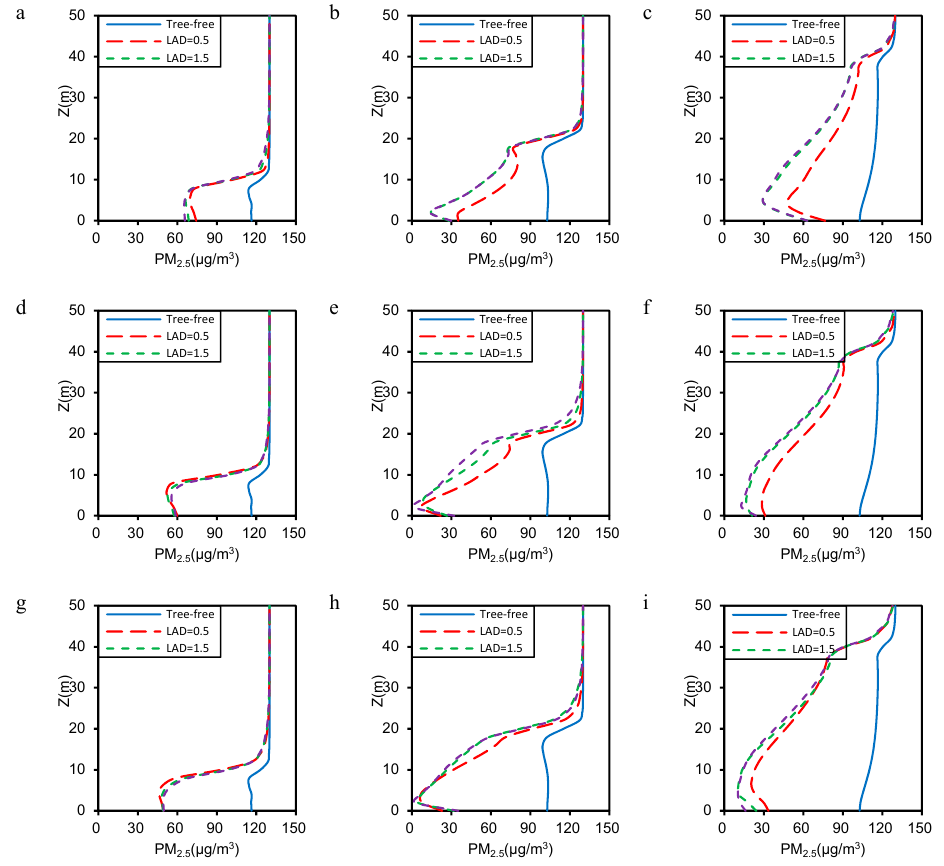
Figure 12. PM 2.5 for H/W = 0.5 ( left ), H/W = 1.0 ( middle ), H/W = 2.0 ( right ) for the conical ( a – c ), spherical ( d – f ), and cylindrical ( g – i ) canopies along the vertical line located at x = 320 m and y = 310 m (Line A from Figure 5).